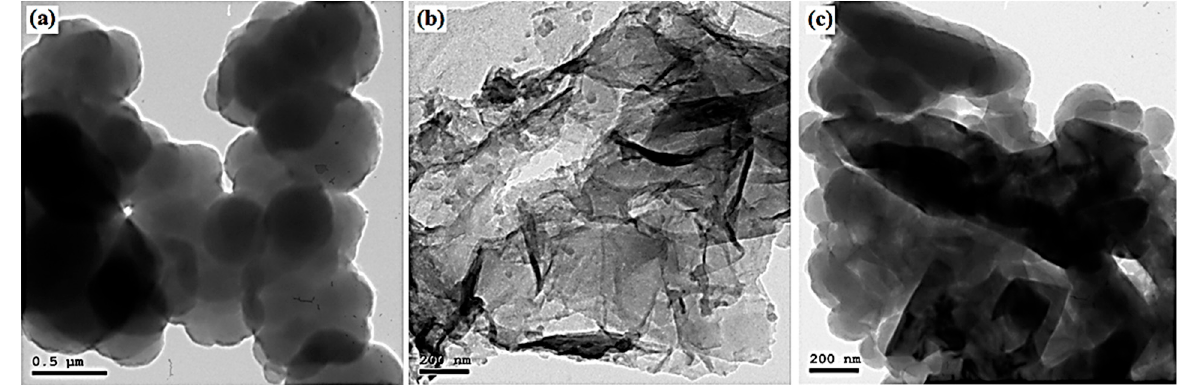
Figure 3. TEM images of ( a ) graphite oxidation product, ( b ) pure PPy, and ( c ) PMG25 composite.